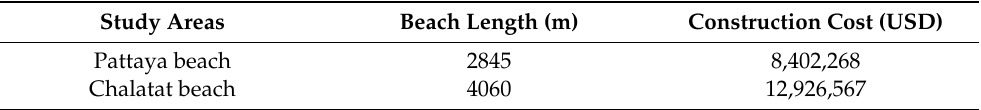
Table 8. Seawall construction